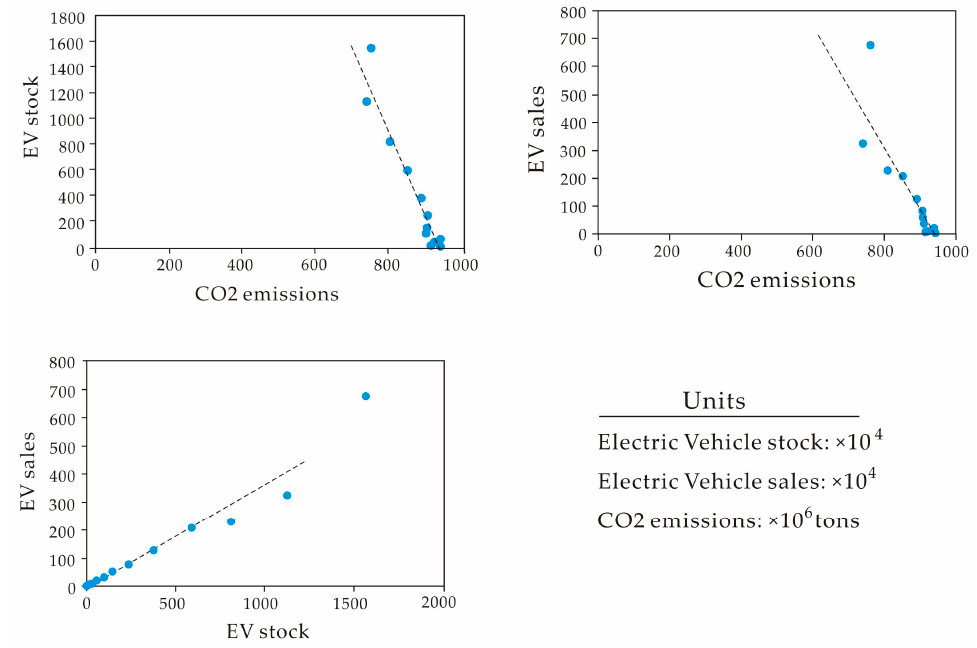
Figure 9. Scatter diagram of correlation between electric vehicle stock, electric vehicle sales, and CO 2 emission from road transport.